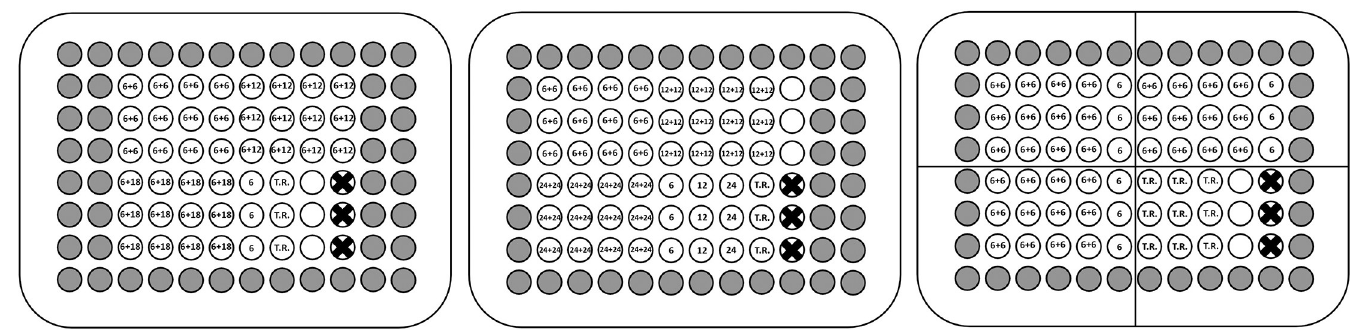
Fig 2. Example of transfection plate layout. Experiments where (A) optimal ratio of gRNA to CRISPR/Cas protein required for precomplexing will be determined, (B) the optimal amount of recombinant CRISPR/Cas will be determined (if we assume the optimal ratio will be 1:1) and (C) optimization of transfection reagent amount (1 × , 2 × and 3 × ) used for complex formation (if we assume the optimal CRISPR/Cas amount is 0.6 pmol per well). Wells named “T.R.” will contain transfection reagent only. White wells will hold non-transfected cells used as non-treated controls for the cell viability assay. The crossed-out wells represent empty wells used for holding the PrestoBlue ™ Cell Viability Reagent staining blank. Grey wells will be filled with PBS to avoid edge effect. All experiments will be performed in triplicate, 4 gRNAs will be used for RNP formation (AAVS1, CDK4 and HPRT1 and non-targeting control gRNA).